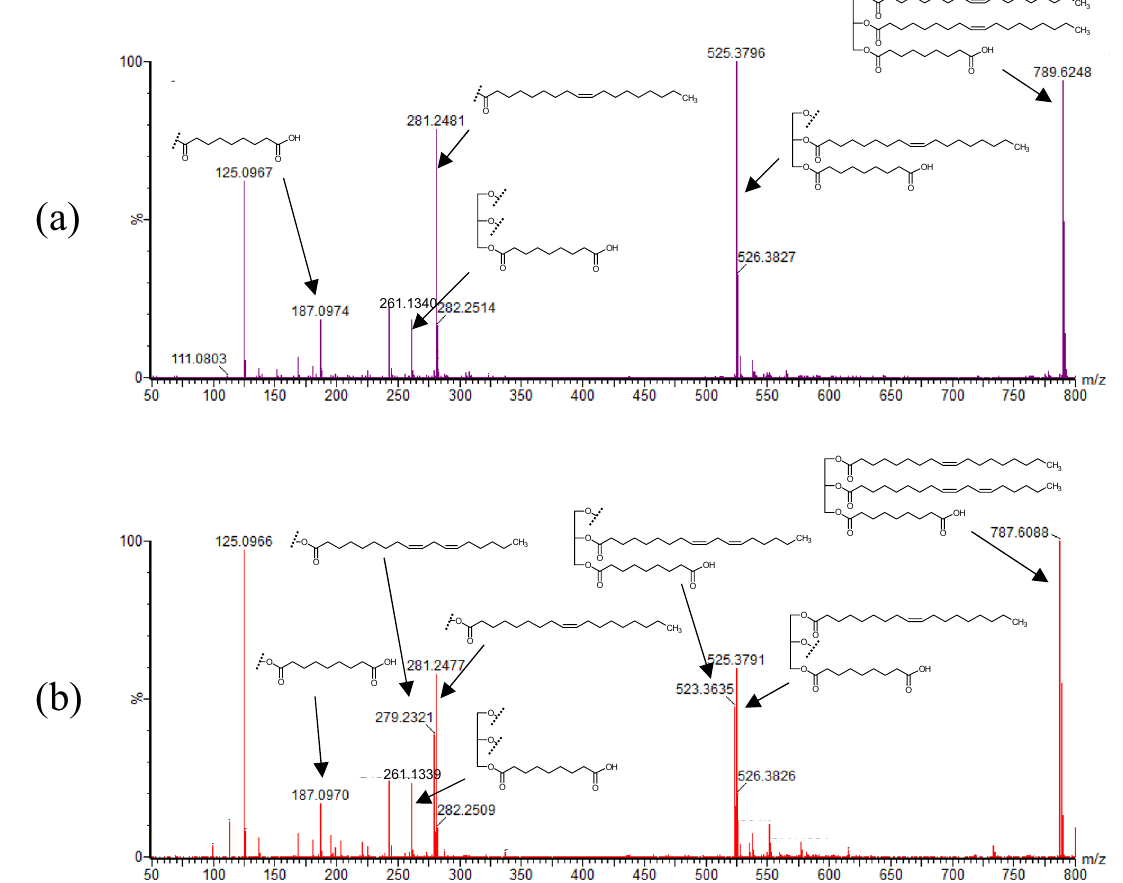
Figure 4. Product ion mass spectra of the target carboxylic acids. Heated canola oil (without ADAM derivatization) was analyzed by UPLC-Tof/MS. m/z 789.6 was selected as a precursor ion for ( a ) and m/z 787.6 was selected as a precursor ion for ( b ). The structures illustrated in this figure are the triacylglycerols bearing nonanedioic (azelaic) acid at the α